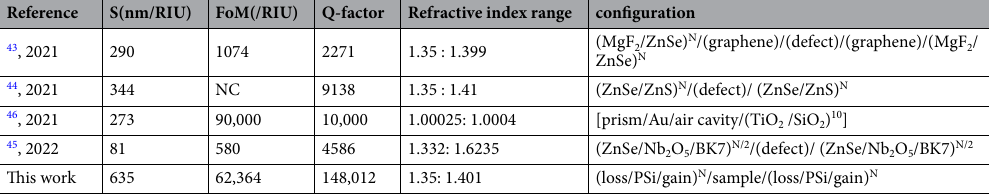
Table 1. Comparative study (NC = not